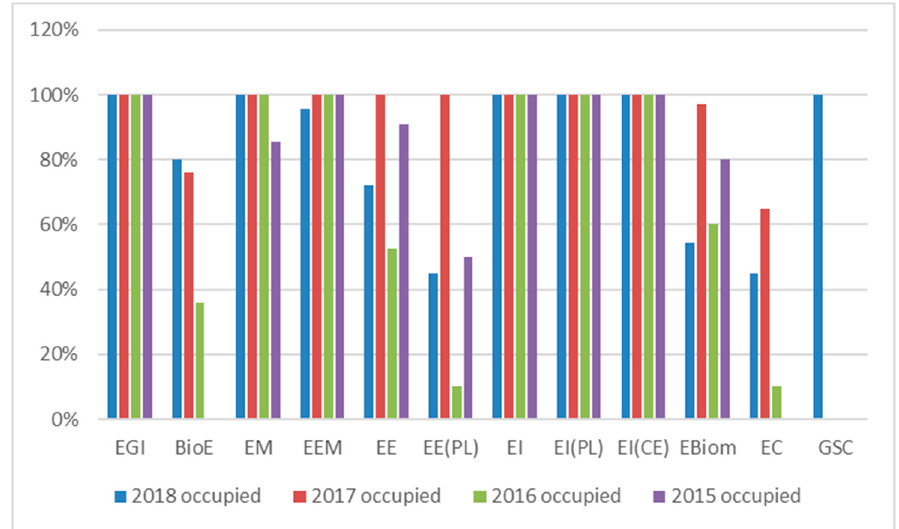
Figure 1. Occupation rate distribution in ISEC, for the three phases of the competition. The most sought-after degrees are EI and EM, filling all the vacancies during the 1st phase of the competition. In 2015 EC had not any candidate and only in 2017 obtained a placement rate of 65%, for 20 available positions. Regarding the general occupation rate, the ISEC reached for the years 2015, 2016, 2017, and 2018, respectively, the values 86%, 79%, 97%, and 88%. To adjust the offer to demand, there was a reduction in the number of vacancies in EBiom, EE and EEM, an increase in EM and the creation of new BioE and GSC degrees.